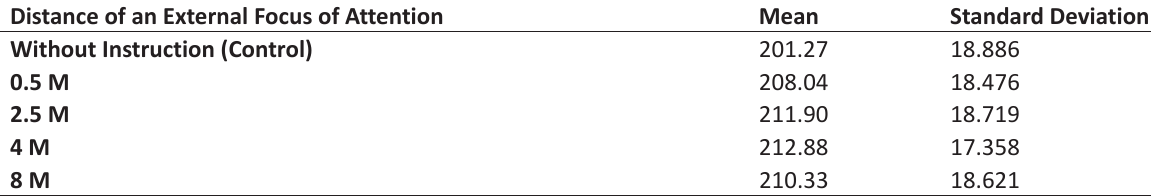
Table 1 : Statistical description of participants’ performance at different attention focuses Distance of an External Focus of Attention Mean Standard Deviation Without Instruction